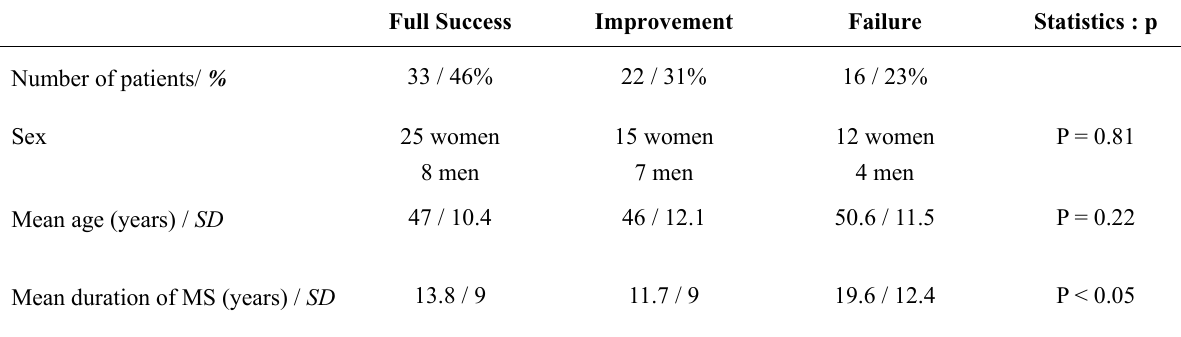
Table 2 - Group analysis: repartition of the patients and demographic